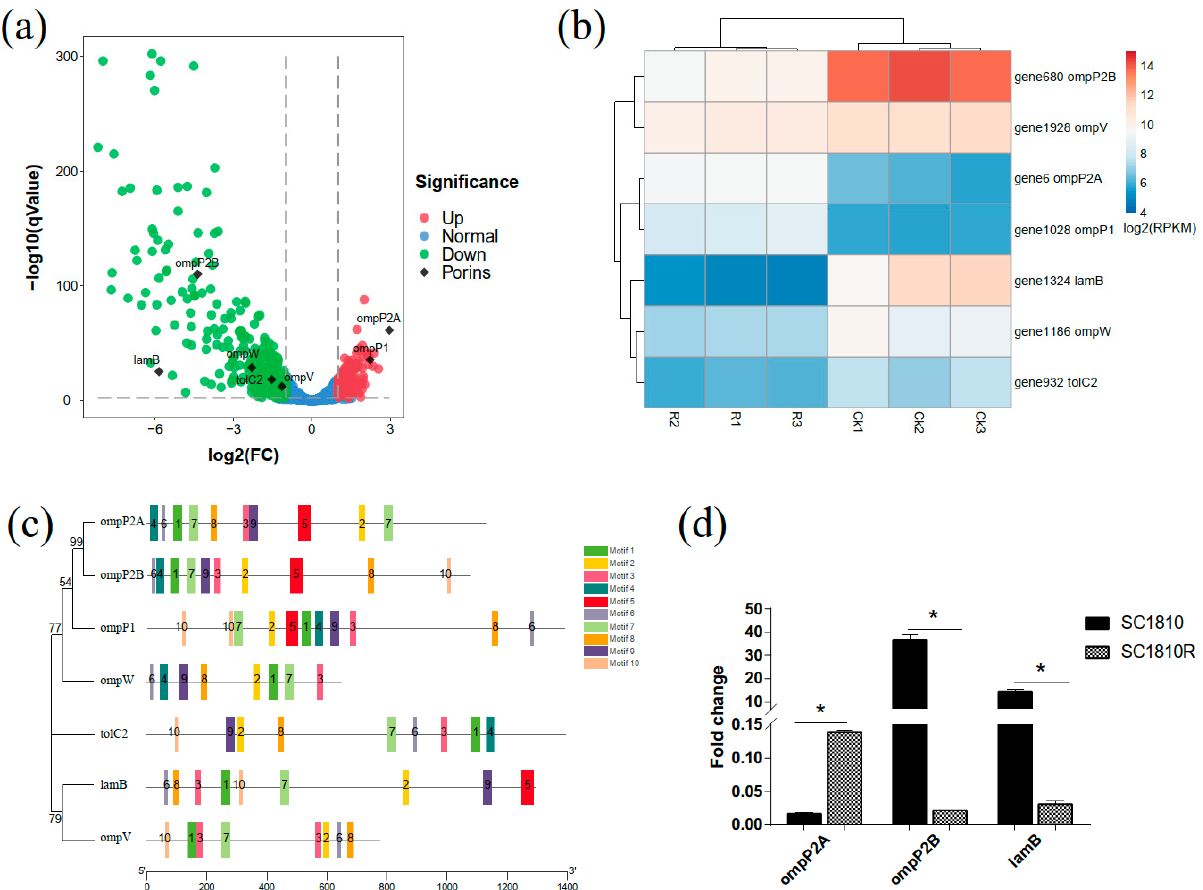
Figure 4. Analysis of differential expression of porins. ( a ) Volcano plots marked with DEGs of porins. ( b ) Each row represents the relative expression of single transcript, and each column represents a sample. Colors represent the log 2 - transformed gene expression level, with red and blue representing high and low expression levels, respectively. ( c ) Molecular phylogenetic analysis by maximum likelihood method and motif prediction. (i) The evolutionary history was inferred by using the maximum likelihood method based on the Tamura 3-parameter model. The percentage of trees in which the associated taxa clustered together is shown next to the branches. (ii) Motifs prediction. The same color or number represents the same conservative site. ( d ) Relative transcription levels of ompP2A , ompP2B and lamB . Data are expressed as mean and standard deviation (SD) of 3 experiments (* p < 0.05).